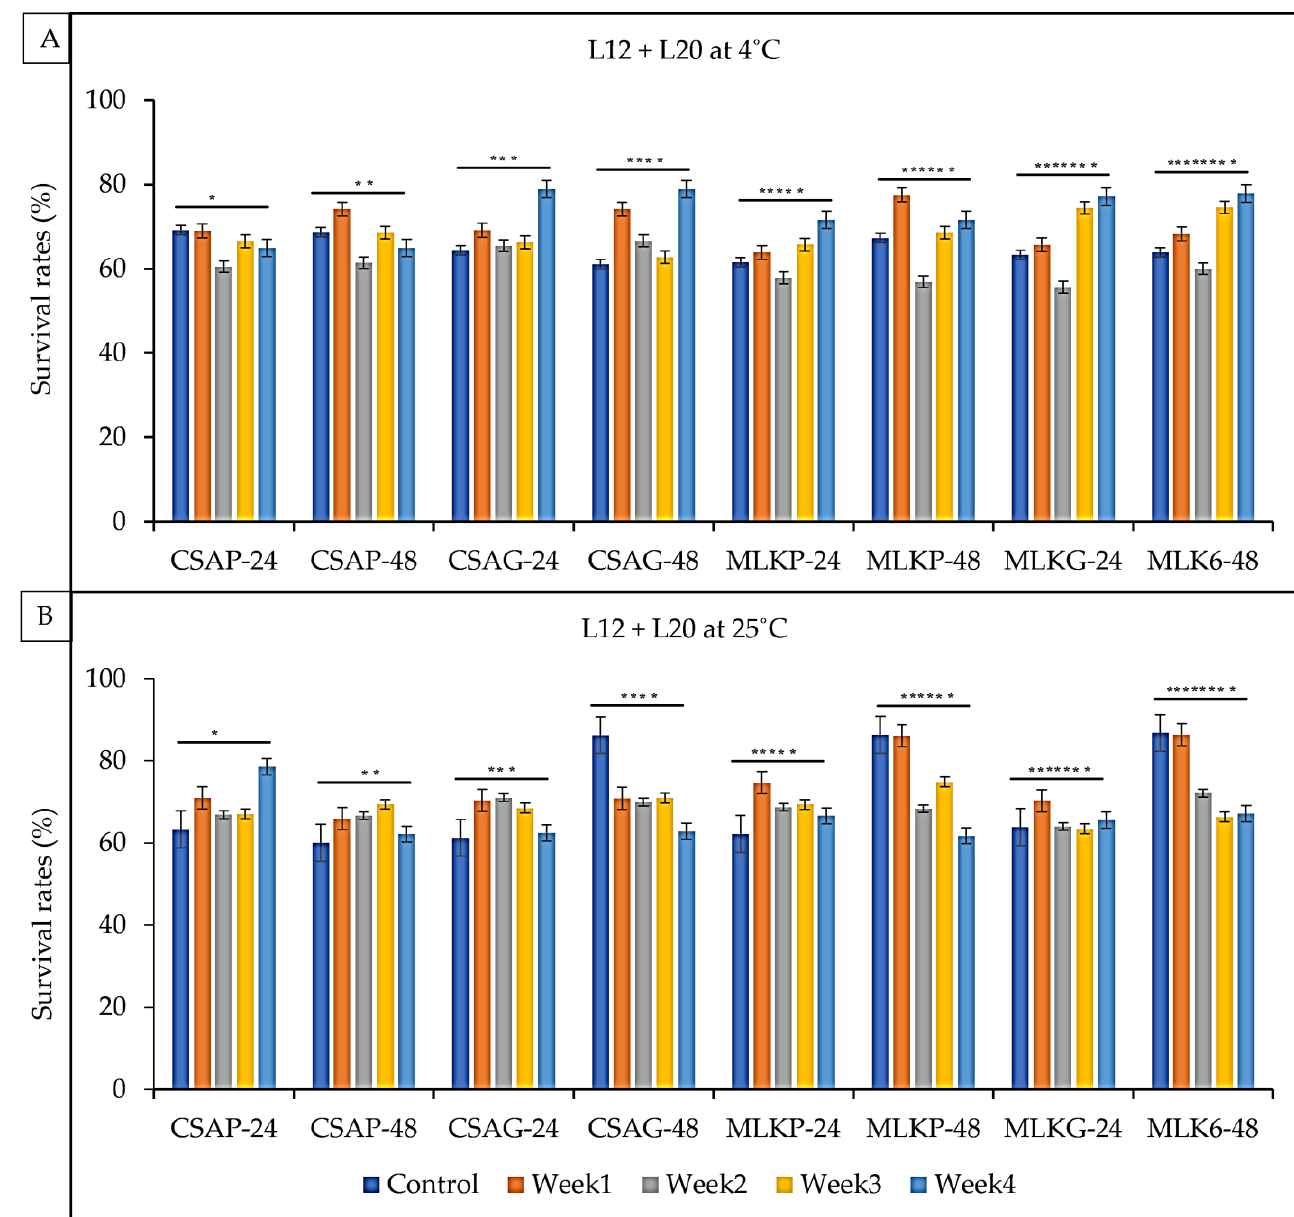
Figure 7. Viability of Lactobacillus delbrueckii (L12) + Leuconostoc mesenteroides (L20) following freeze- drying. ( A ) Survival rates at ambient temperature (25 °C), and ( B ) survival rates at refrigerated tem- perature (4 °C) for 24 h and 48 h. CSAP-24-Cassava in plastic at 24 h, CSAP-48-Cassava in plastic at 48 h, CSAG-24-Cassava in glass at 24 h, CSAG-48-Cassava in glass at 48 h, MLKp-24-Milk in plastic at 24 h, MLKP-48-Milk in plastic at 48 h, MLKG-24-Milk in glass at 24 h, MLKG-48-Milk in glass at 48 h (Values represent means of three replicate experiments, ±: standard deviation). For ( A ) * p -value = 0.00053, ** p -value = 0.00000, *** p -value = 0.00002, **** p -value = 0.000000, ***** p -value = 0.000080, ****** p -value = 0.000383, ******* p -value = 0.02219, ******** p -value = 0.000086. For ( B ) * p -value = 0.000940, ** p -value = 0.125886, *** p -value = 0.001581, **** p -value = 0.000159, ***** p -value = 0.03362, ****** p -value = 0.42607, ******* p -value = 0.08091, ******** p -value = 0.007825.